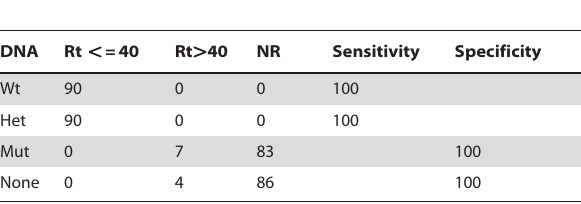
Table 1. Qualitative analysis of the results from the genomic DNAs vs Wt probes.